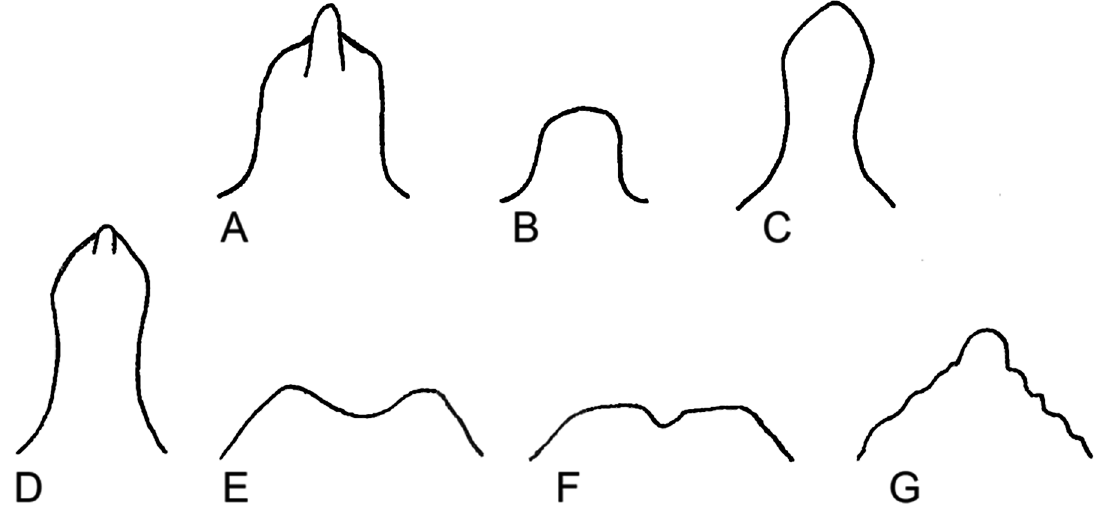
Fig. 5. Sternal process on body ring 6 . A . Emphysemastix spp. B . Agrophogonus spp. except A.